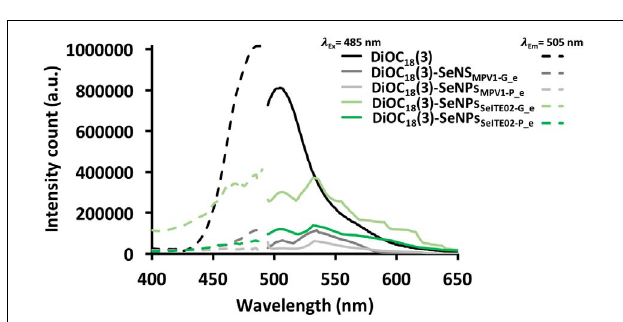
FIGURE 8 | Fluorescence emission and excitation spectra of DiOC 18 (3) labeled biogenic SeNS